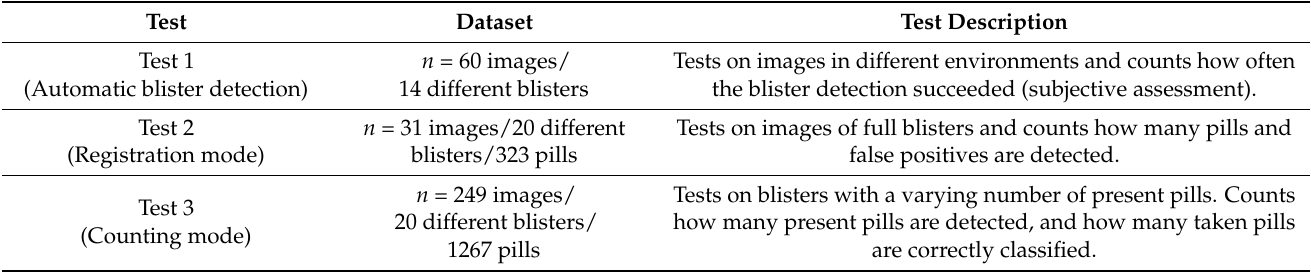
Table 1. Experimental validation plans.